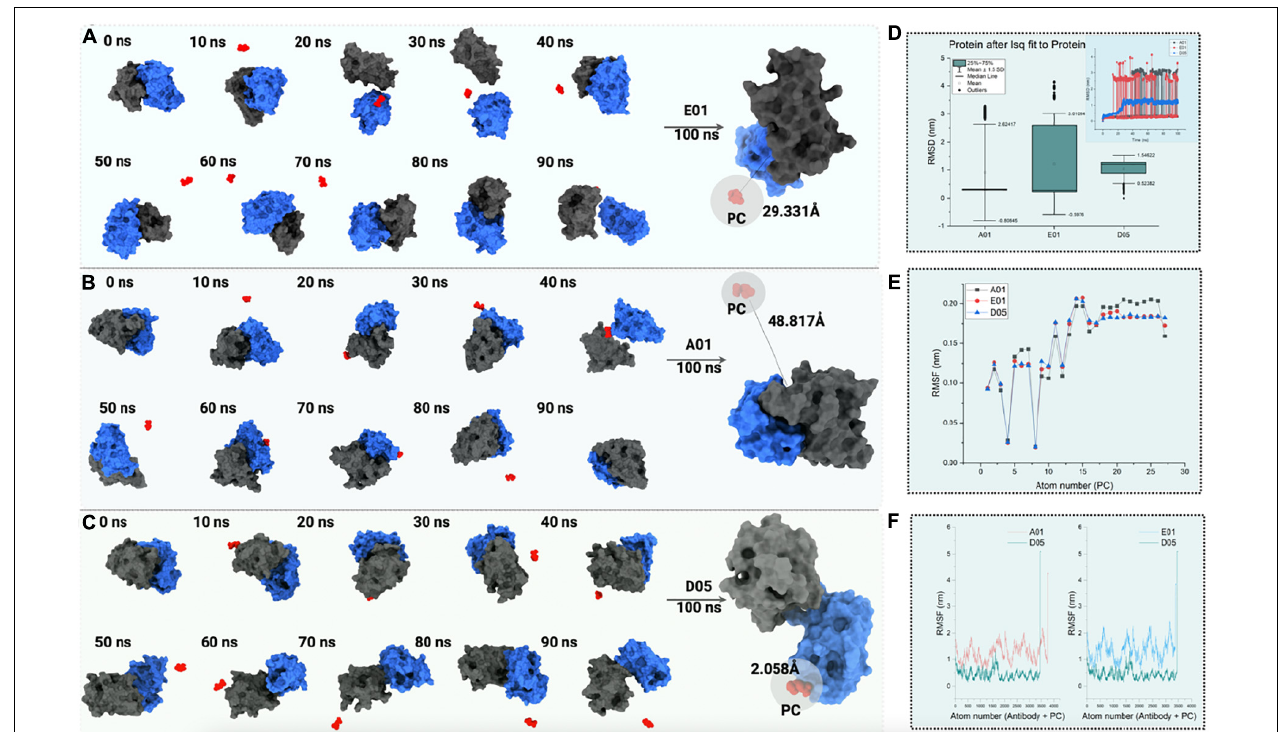
FIGURE 7 | The 100 ns all-atom molecular dynamics simulation of PC with (A) E01, (B) A01, and (C) D05 clone antibodies. The conformations of PC binding to clone antibodies during the course of the 100 ns simulation (D) root mean square deviation (RMSD) analysis (nm). The box plot represents the deviation in RMSD with standard deviation depicted as mean ± 1.5 SD. (E) Line plot illustrating root mean square fluctuation (RMSF in nm) for PC molecule. (F) RMSF (in nm) for complex anti-PC clones with a comparison of D05 anti-PC clone with other